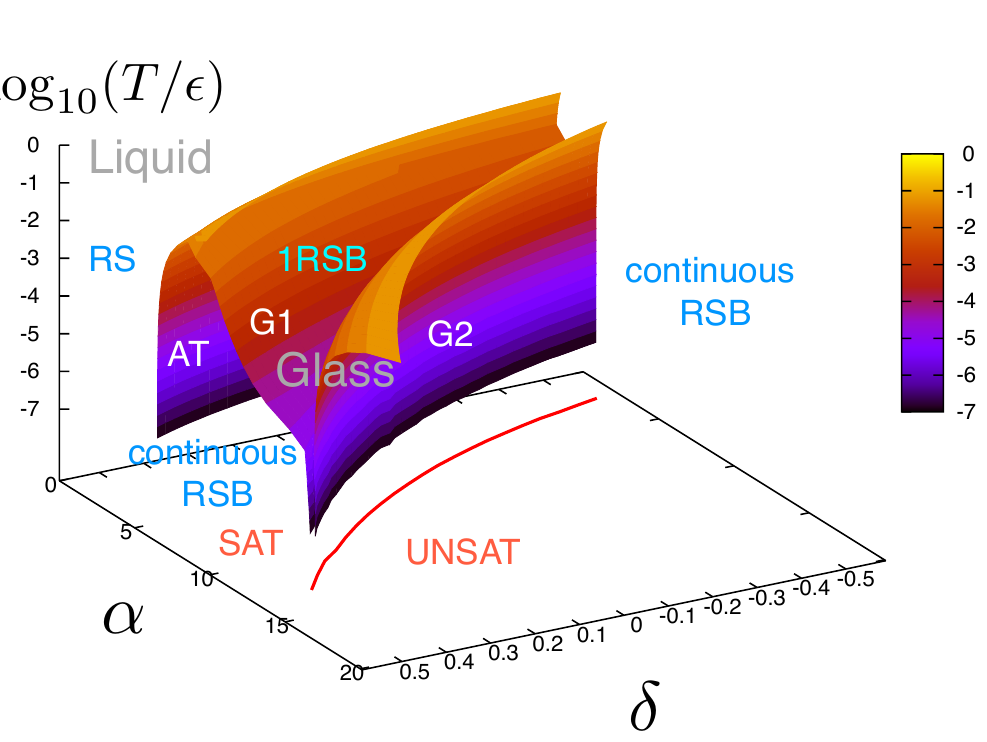
Figure 8: Phase diagram of the soft / hardcore model ( p = 2). On the plane AT sepa- rating the liquid (RS) and glass (RSB) the d’Almeida-Thouless (AT) instability occurs. The 1RSB solution becomes unstable below the two planes G1 and G2 on which the Gardner transition occurs. The G1 plane separates from the AT plane at finite tem- peratures. The red line on the bottom represents the jamming line α = α T =